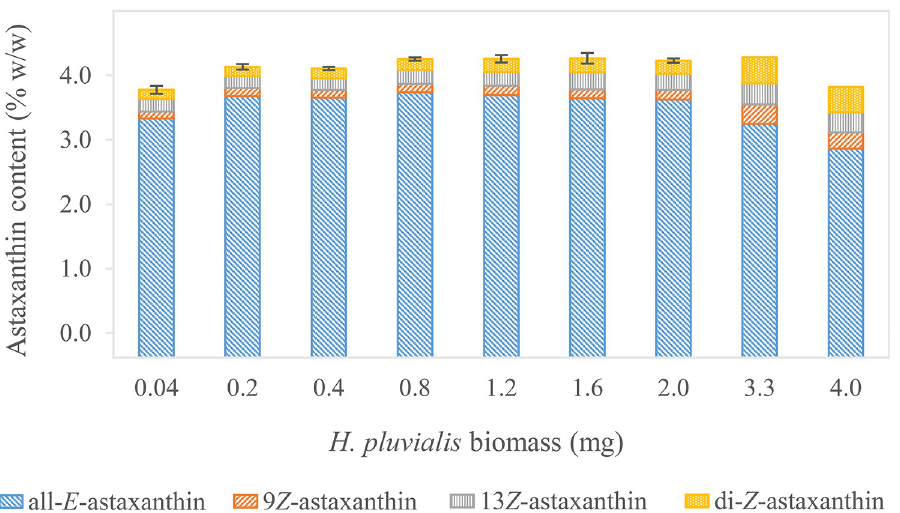
Fig 5. Astaxanthin content in H . pluvialis biomass, deesterified with 2.0 units of cholesterol esterase. Standard deviation is indicated for total astaxanthin in triplicates. Standard deviations for the individual isomers can be found in S1 Table. The figure demonstrates that the method gets similar results for a broad range of biomass